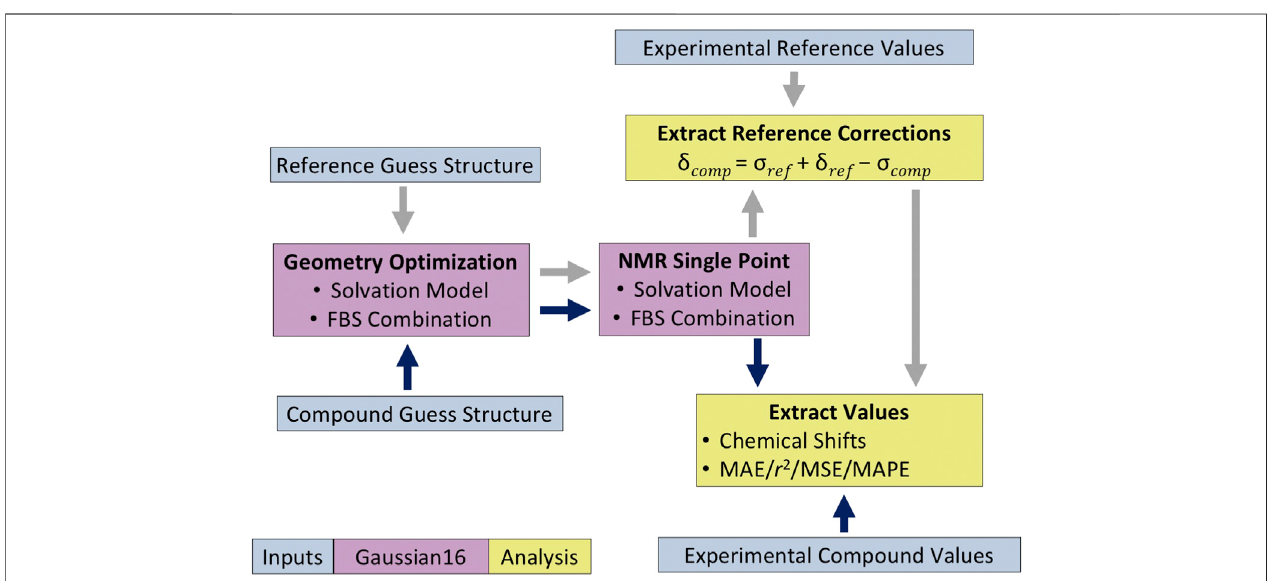
FIGURE 3 | Protocol for quantum mechanical (QM)-based nuclear magnetic resonance (NMR) shift calculations. The dark blue and gray arrows indicate the analysis methodology for the compound of interest and the reference compound,